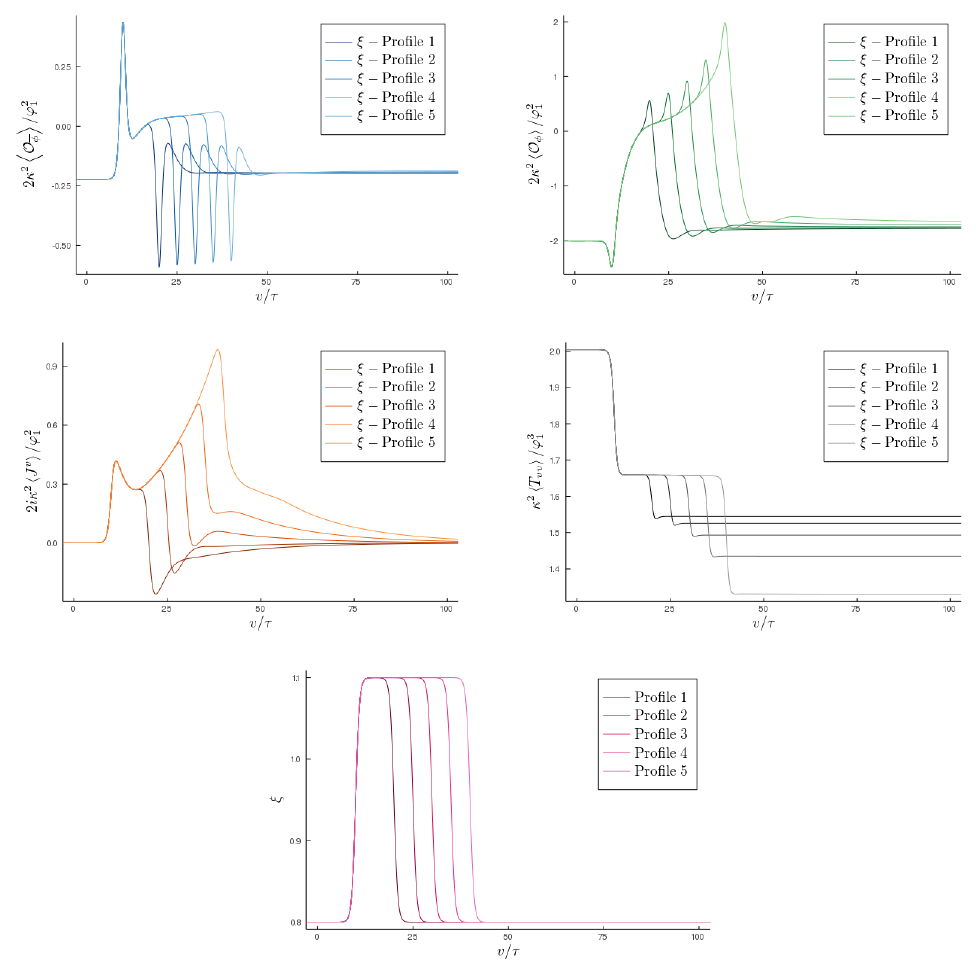
Figure 5: Expectation values 2.22 for a quench with profile 3.2 for / ˜ τ = { 20,25,30,35,40 } . The initial and final states are located at ξ = ˜ v m